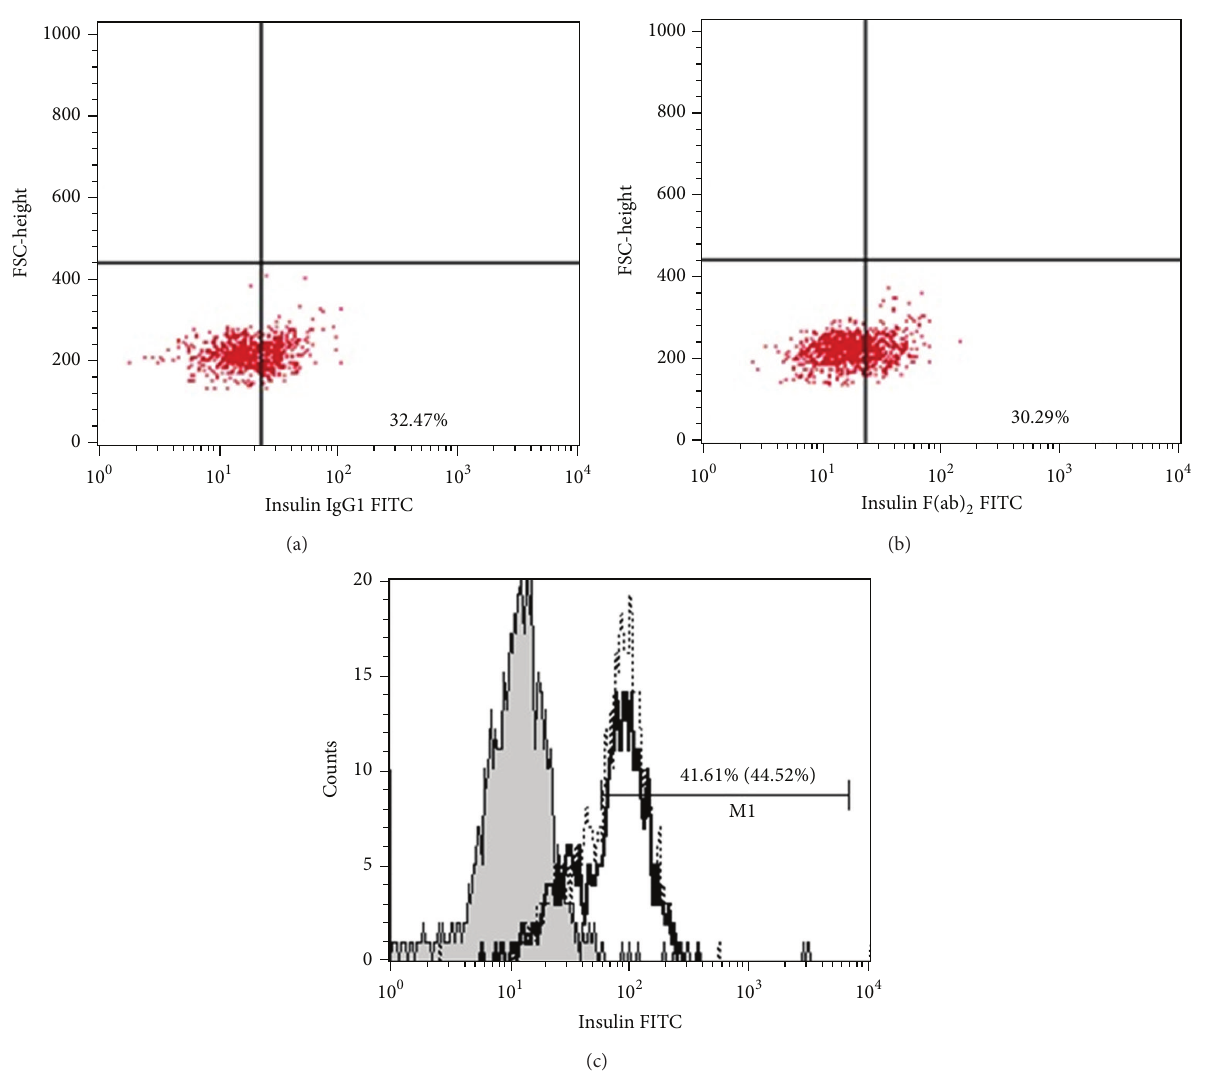
Figure1:DetectionofC-peptideexpressionbyflowcytometry.((a),(b))Thedotplotsshowrepresentativedataforonesample,illustratingthe analysis of C-peptide of proinsulin in MSCs differentiating into insulin producing cells (IPSs). Indirect, intracellular flow cytometry analysis of fixed and permeabilized insulin producing cells (IPSs) stained with mouse anti-human C-peptide of proinsulin primary antibody. Samples treated with primary antibody were next exposed to (a) goat anti-mouse monoclonal IgG 1 FITC or (b) FITC-conjugated goat anti-mouse IgG F(ab 󸀠 ) 2 . (c) C-peptide expression in differentiated IPCs from next culture plotted as a histogram. Grey histogram represents an isotype control. Open histograms represent the expression of C-peptide staining with goat anti-mouse monoclonal IgG 1 FITC (black solid line) or with FITC-conjugated goat anti-mouse IgG F(ab 󸀠 ) 2 (dotted line). The numbers in histograms are the percentage of C-peptide positive cells from samples stained with secondary IgG1 or IgG F(ab 󸀠 ) 2 (between brackets). The 𝑥 -axis corresponds to logarithmic fluorescence intensity and the 𝑦 -axis to relative cell